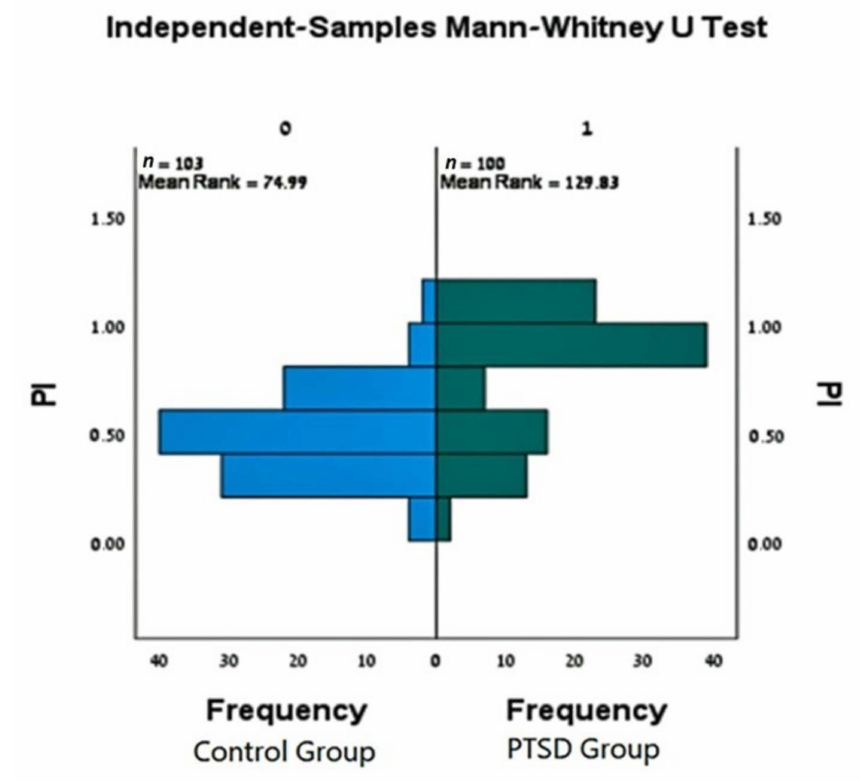
Figure 1. Plaque Index